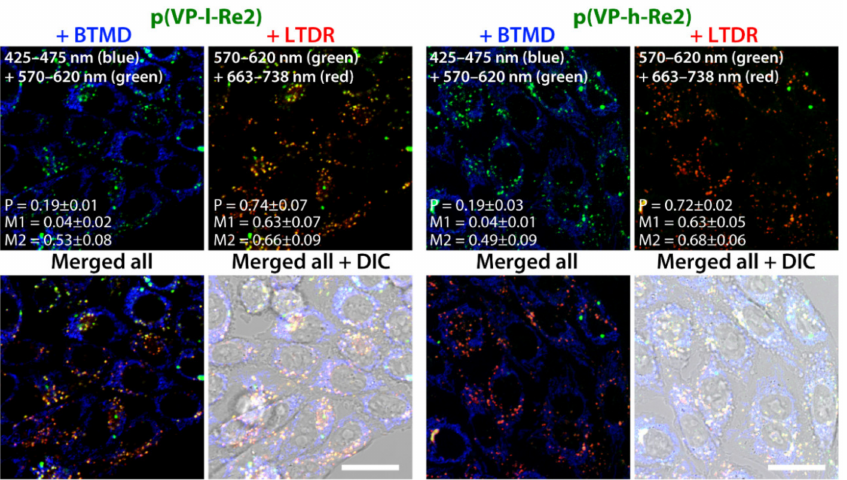
Figure 7. Subcellular distribution of BioTracker 405 Blue Mitochondria Dye (BTMD, blue, 425–475 nm), p(VP-l-Re2) and p(VP-h-Re2) (green, 570–620 nm, 5 µ M, 24 h), and LysoTracker Deep Red (LTDR, red, 663–738 nm) in living CHO-K1 cells. Pearson’s (P) and Manders’ overlap coefficients (M1—fraction of first channel that overlaps second channel, M2—fraction of second channel that overlaps first channel) are presented as mean ± standard deviation calculated for 25 cells. Scale bar 20 µ